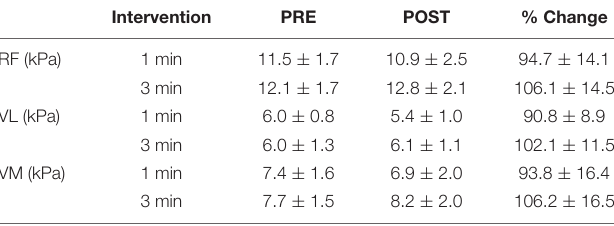
TABLE 1 | Changes in the shear elastic modulus (Experiment 1).